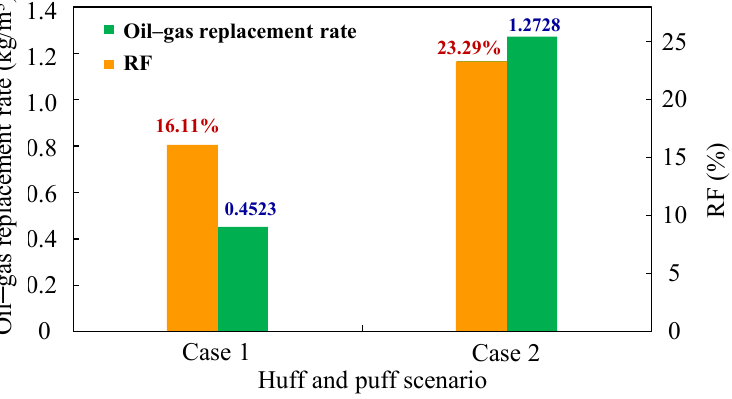
Figure 11. Oil–gas replacement rate of case one and case two.